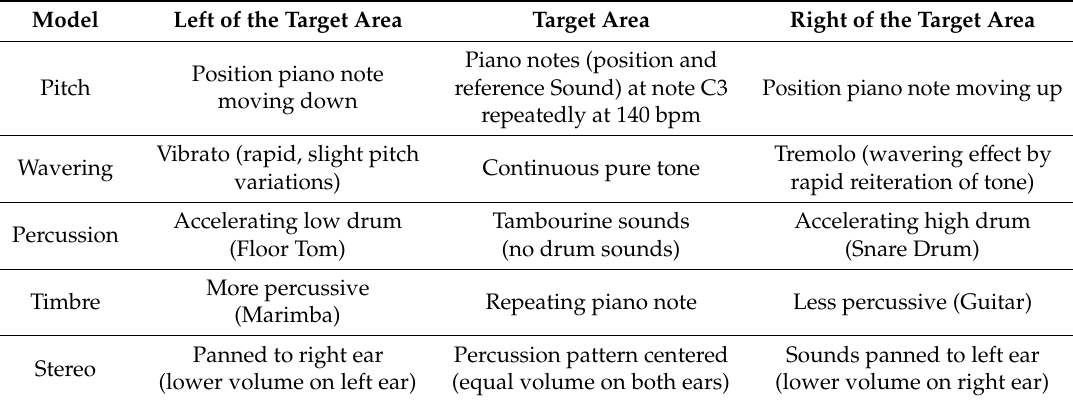
Table 1. Sound characteristics of the one-dimensional models in